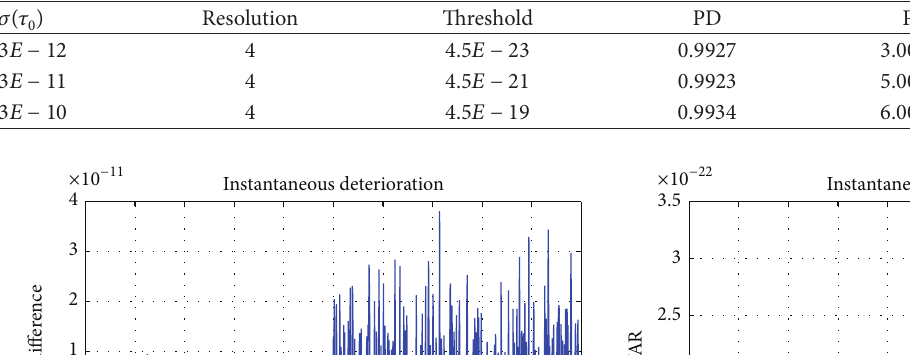
Table 9: Detection performance of frequency jumping for different clock stability.